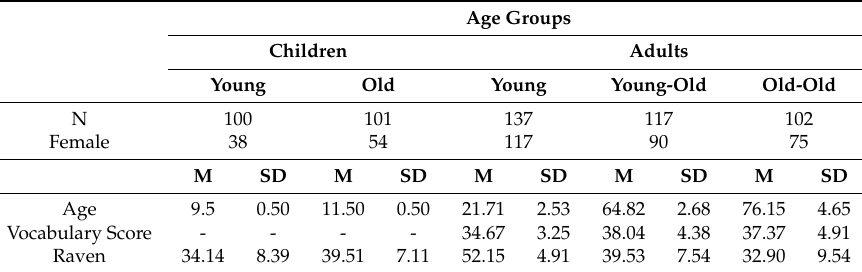
Table A1. Participants’ Characteristics by Age Group.